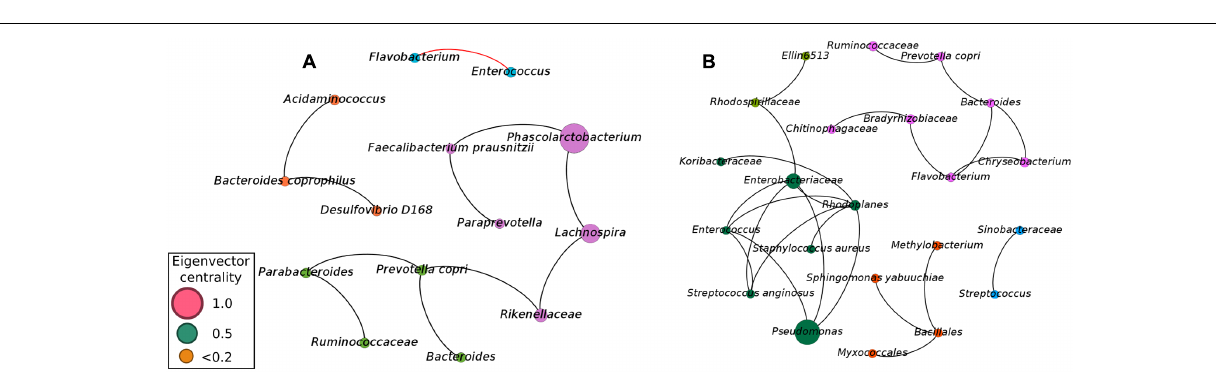
FIGURE 2 | Co-occurrence network of the microbial community found in meconium samples (first evacuation) of preterm infants not diagnosed with NEC (A) and preterm infants with subsequent diagnostic of NEC (B) . A connection stands for a strong Pearson’s correlation ( p ≥ 0.7 and p -value ≤ 0.05). Each node represents an Operational Taxonomic Unity (OTU) grouped at 97% similarity cutoff and node sizes are proportional to the value of eigenvector centrality of each taxa. Black lines represent the positive significant correlations and red lines represent the negative significant correlations. The colors of the circles represent the bacterial